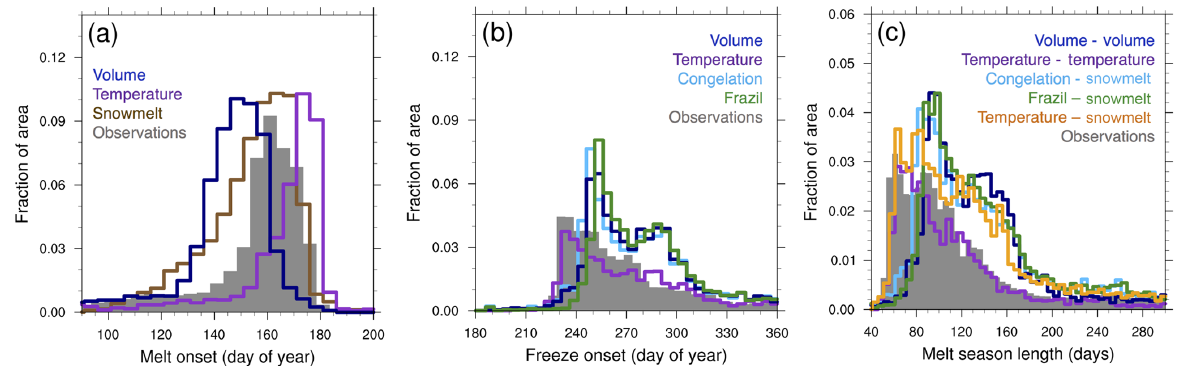
Figure 10. Average melt season characteristics from 66 to 84.5 ◦ N for 1979–2014 for PMW satellite observations (filled gray) and each CESM LE definition (in ensemble member 35): (a) melt onset using the surface temperature, thermodynamic ice volume tendency and snowmelt definitions, (b) freeze onset using the surface temperature, thermodynamic ice volume tendency, frazil ice growth and congela- tion ice growth definitions and (c) melt season length using the temperature–temperature, temperature–snowmelt, volume–volume, frazil– snowmelt and congelation–snowmelt definitions. Plots from ensemble member 34 are very similar and are shown in Fig.